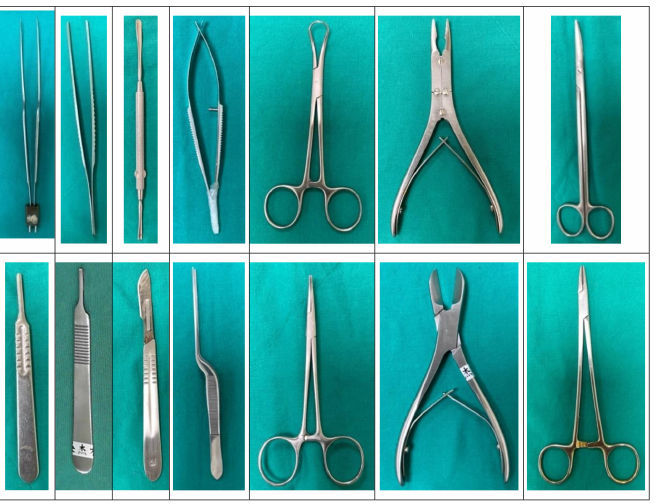
Figure 2. Examples of each of the instruments to be recognized, in no particular order.